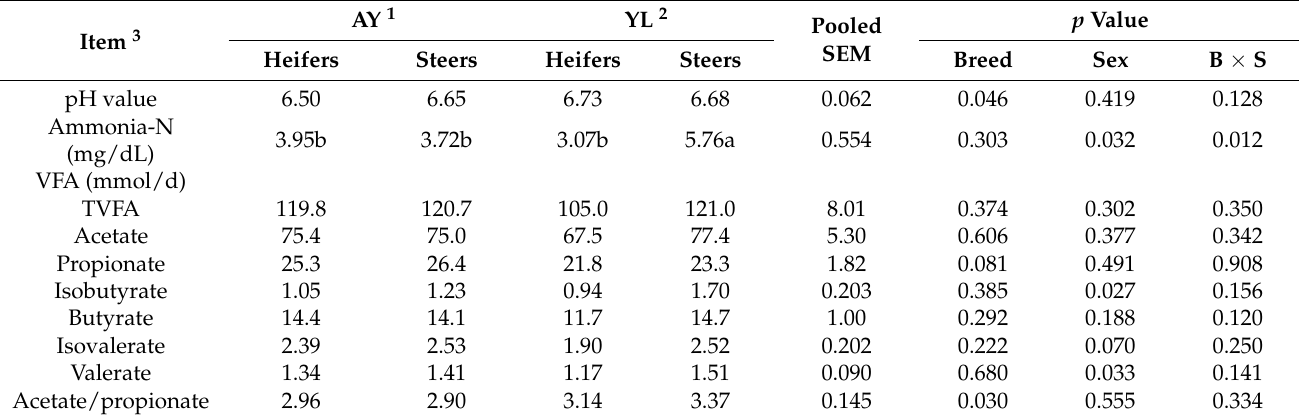
Table 3. The effects of breed and sex on serum rumen fermentation of cattle.